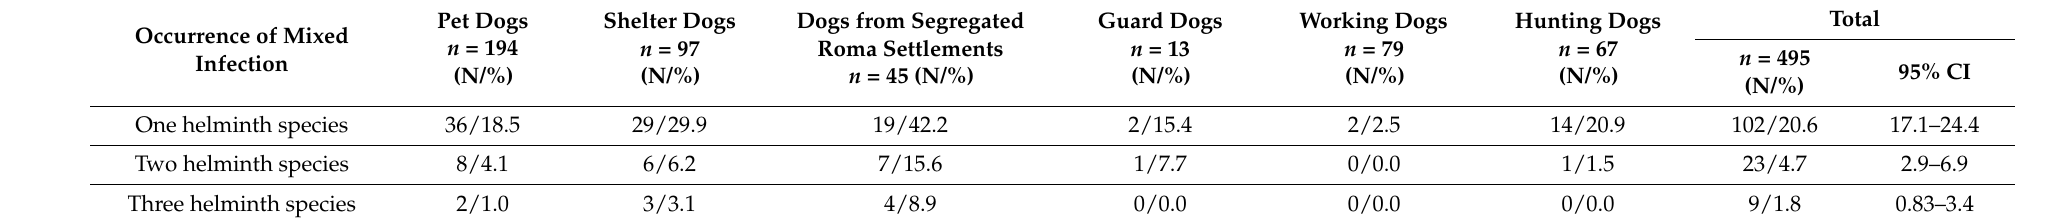
Table 2. Occurrence of mixed infections in